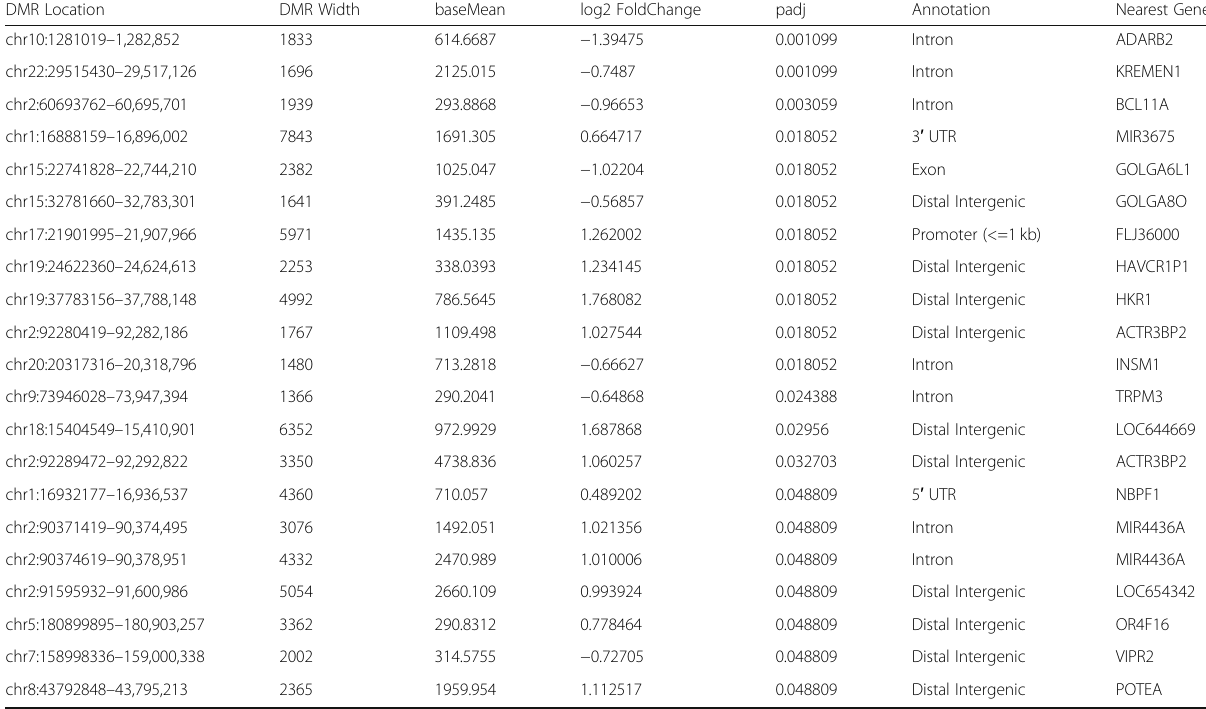
Table 2 Annotated DMR ’ s Associated with Preterm Birth DMR